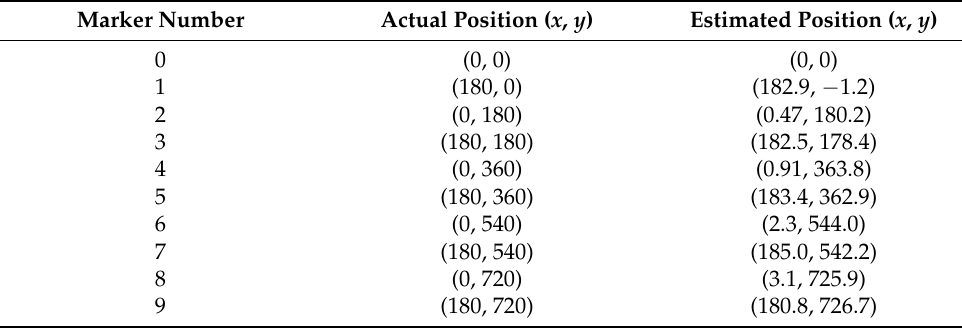
Table 4. Positions of